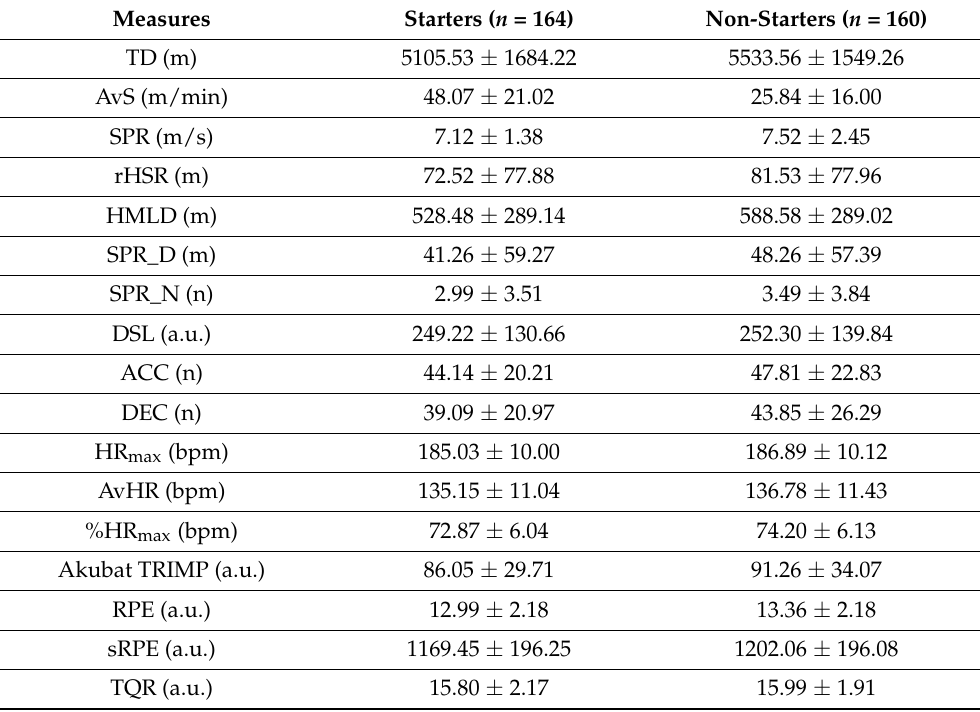
Table 2. Mean weekly training load according to the player’s starting